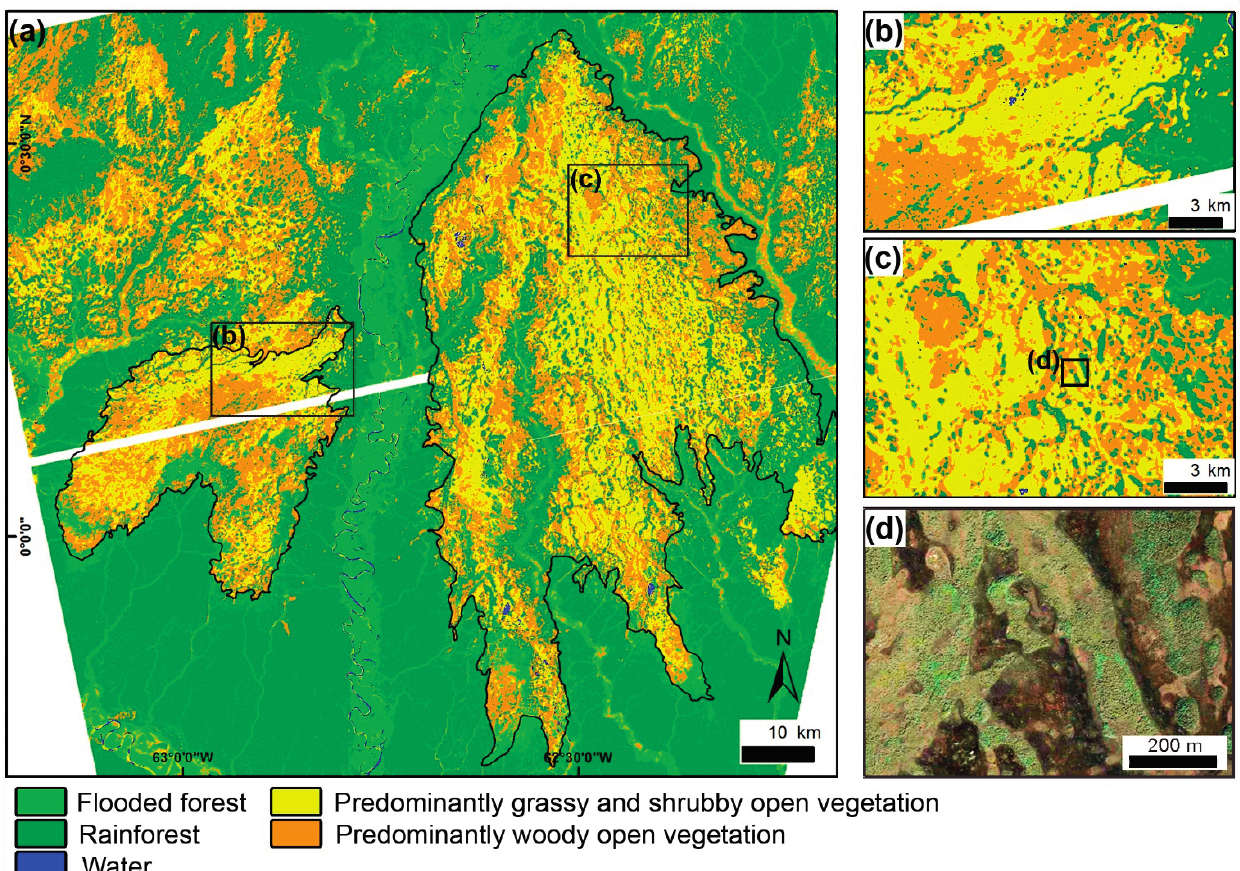
( d ) GeoEye image from Google Earth ® illustrating the distribution of phytophysiognomies in the study